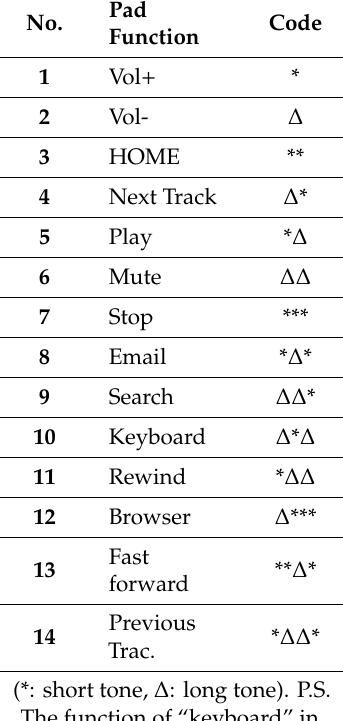
The function of “keyboard” in pad mode table is virtual apple keyboard